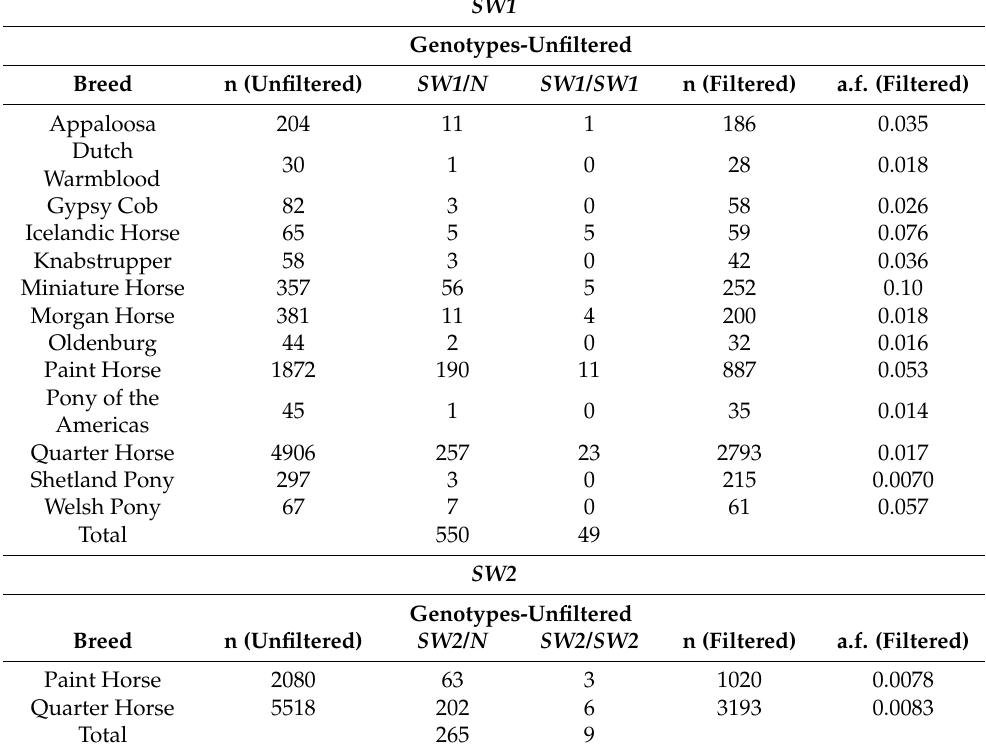
Table 6. Number of individuals tested (n), genotypes, and estimated allele frequencies (a.f.) for splashed white variants SW1 – SW6 after filtering for